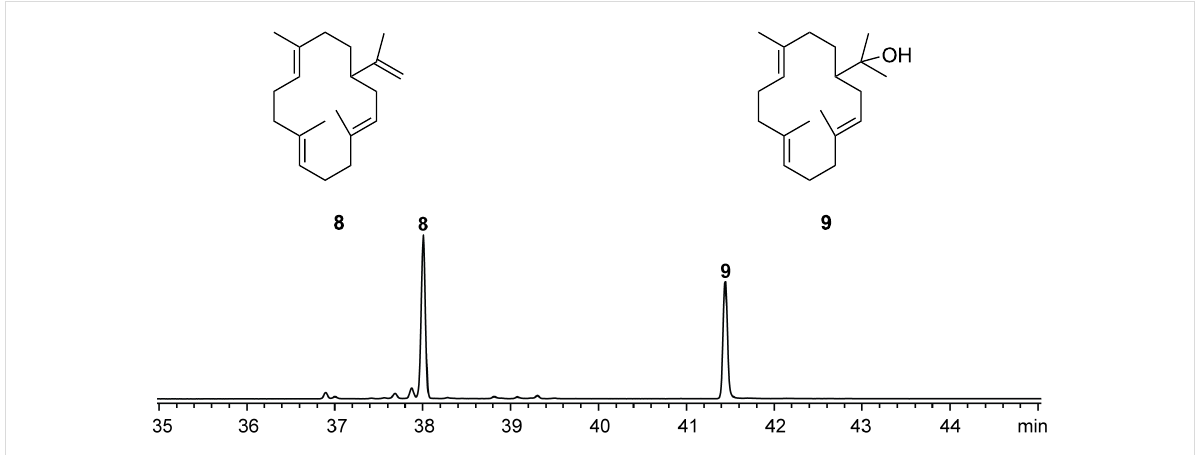
increase is not clear, but the introduced Asp in the Q227D variant is homologous to D225 of SdS that hydrogen bridges to the pyrophosphate sensor R178 (Figure 1). As SmTS1 does not contain this Arg residue, but a Gly instead, the opened space in this region could allow for direct hydrogen bonds between Q227 and the substrate’s diphosphate, which may become even stronger in the Q227D variant, explaining its higher catalytic efficiency. Future structural work on SmTS1 and its Q227D de- rivative is required to clarify this effect. The R242N substitu- tion showed almost no consequences for total production (94 ± 17%) and yields of individual compounds, while for the F307W variant the overall yield dropped to 53 ± 6% with simi- lar product ratios as for the wildtype, which may again have steric reasons. Taken together, these results demonstrate that residues found to be highly conserved and known to be critical for enzyme function in type I TPSs can in some cases be natu- rally substituted by other residues without consequences on the enzyme activity. Similar observations were recently made for spiroalbatene synthase from Allokutzneria albata , in which the otherwise highly conserved Ser within the NSE triad is natu- rally substituted by Gly. In this case, the G229S enzyme variant did not yield any soluble protein, possibly because the confor- mational flexibility of Gly is critical for correct enzyme folding [13]. At the same time our results demonstrate that such unusual residues are of interest for protein engineering and may lead to significantly increased yields, if altered to the otherwise ob- served conserved residues, as demonstrated for the Q227D en- zyme